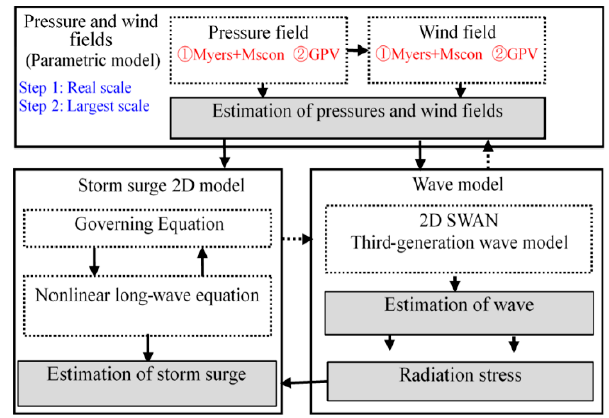
Figure 4. Foundation of storm surge models in this study.